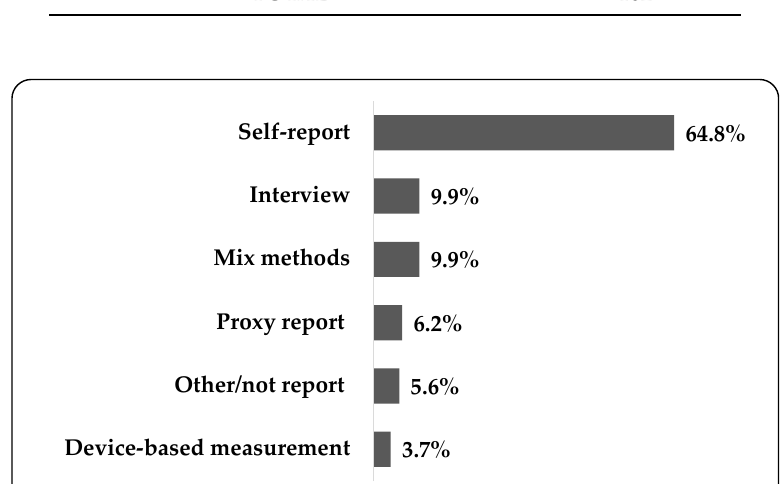
Figure 3. The proportion of data collection methods of SB (mixed method: the use two or more methods, e.g., a questionnaire and an accelerometer).